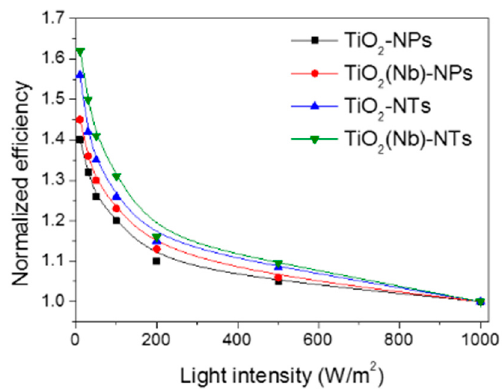
Figure 6. Normalized efficiency of pristine and Nb-doped TiO 2 NPs- and NTs-based DSCs operated under various light intensities.